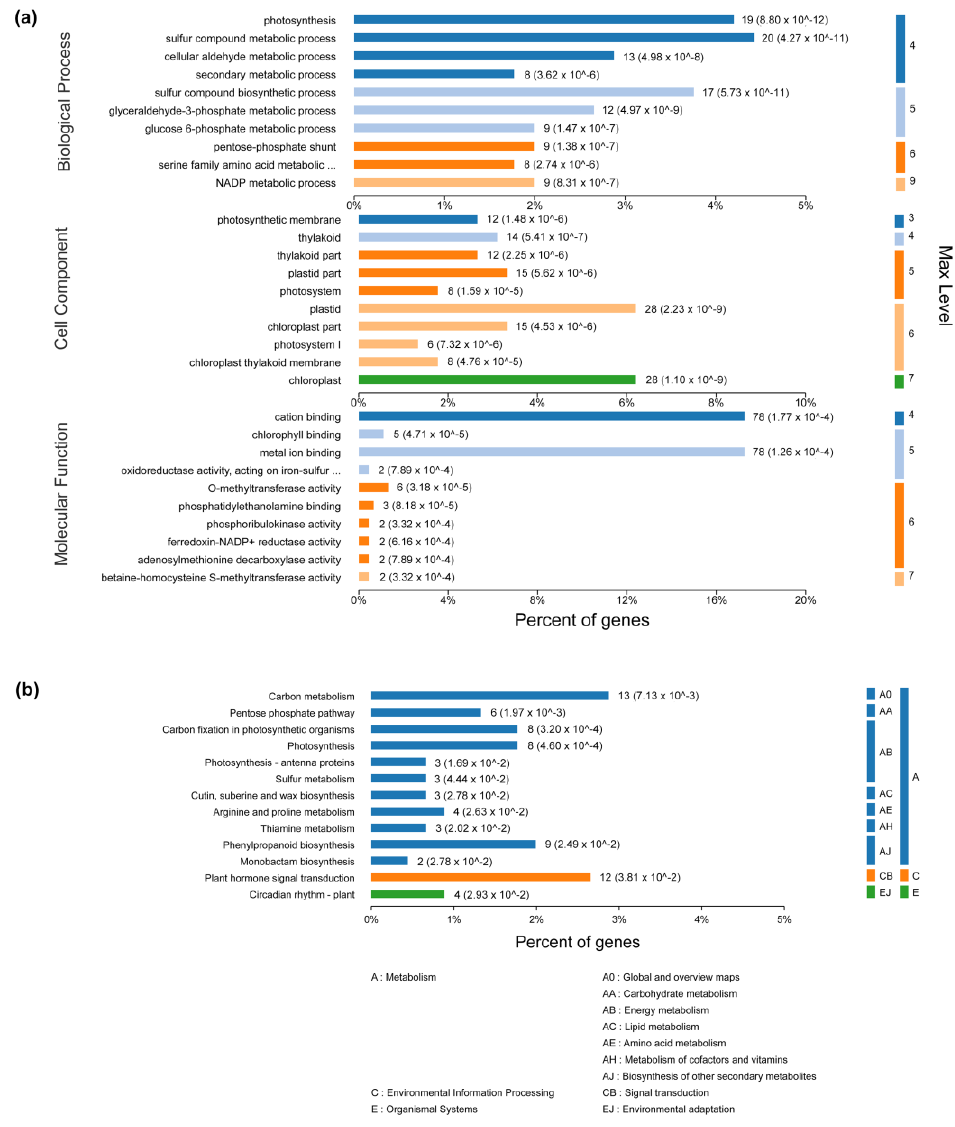
Figure 4. Enrichment analysis of differentially expressed genes (DEGs). ( a ) The results are summarized in three main categories: biological process; cellular component; and molecular function. The x -axis indicates the number and percent of genes in each category. The y -axis indicates the most enriched GO terms in the three main categories. Max level indicates maximal annotated level of the term in the GO graph. ( b ) KEGG enrichment analysis of 2146 DEGs. The x -axis indicates the percent of genes, and the y -axis indicates pathway.